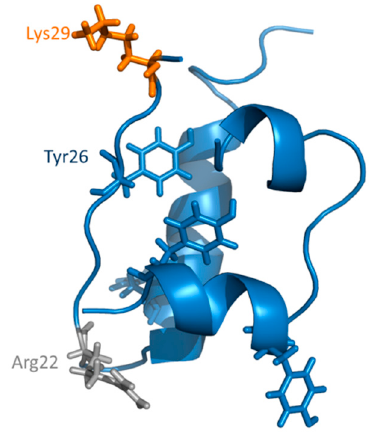
Figure 4. Glycation sites in human insulin. Structural representation of human insulin in its mono- meric form (PDB 3AIY). In the tridimensional structure, D -ribose glycation site is represented in orange (Lys29), MG glycation site in gray (Arg22), and tyrosine residues are shown in blue.